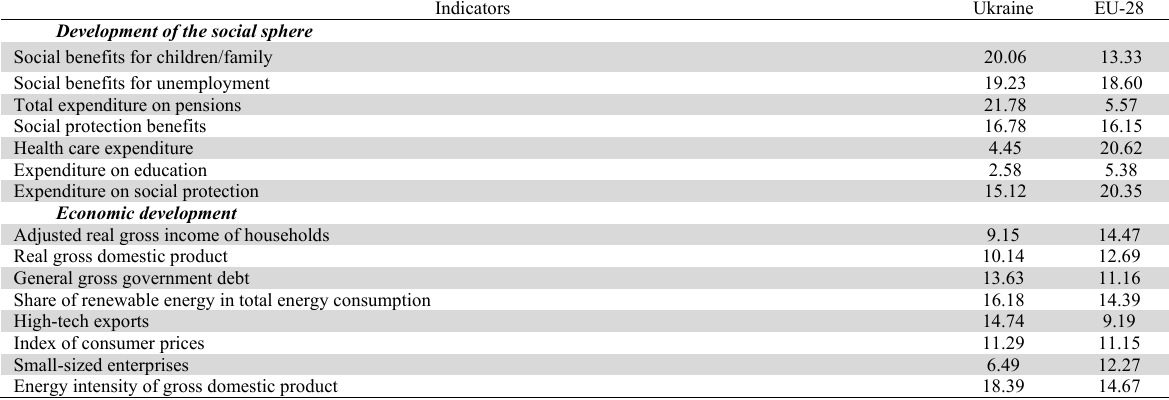
Weight coefficients of indicators in the integral index of social and economic development, per cent Indicators Social benefits for